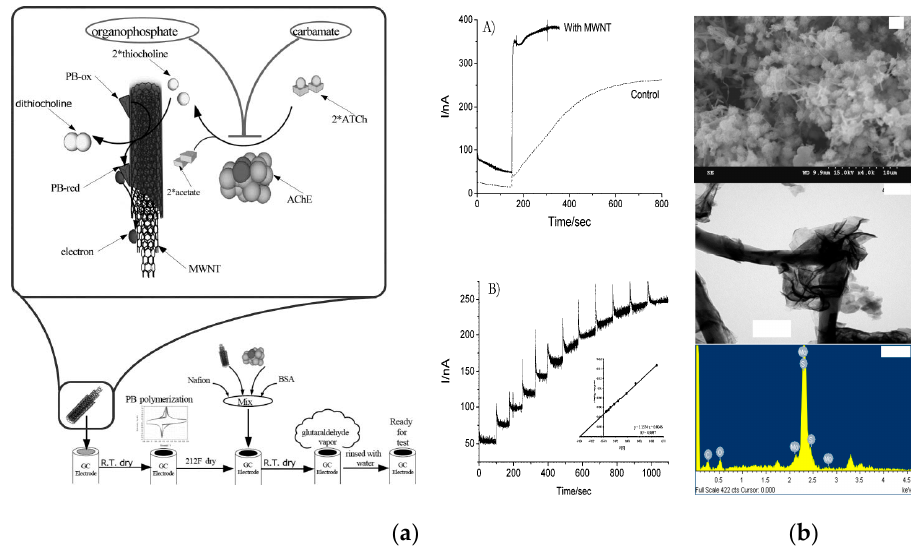
Figure 2. Significant performance of electrochemical sensors based on MWCNT materials. ( a ) Significant performance of electrochemical sensors based on MWCNT AChE/PB/MWNT electrochemical sensor for pesticide detection. Reproduced with permission from